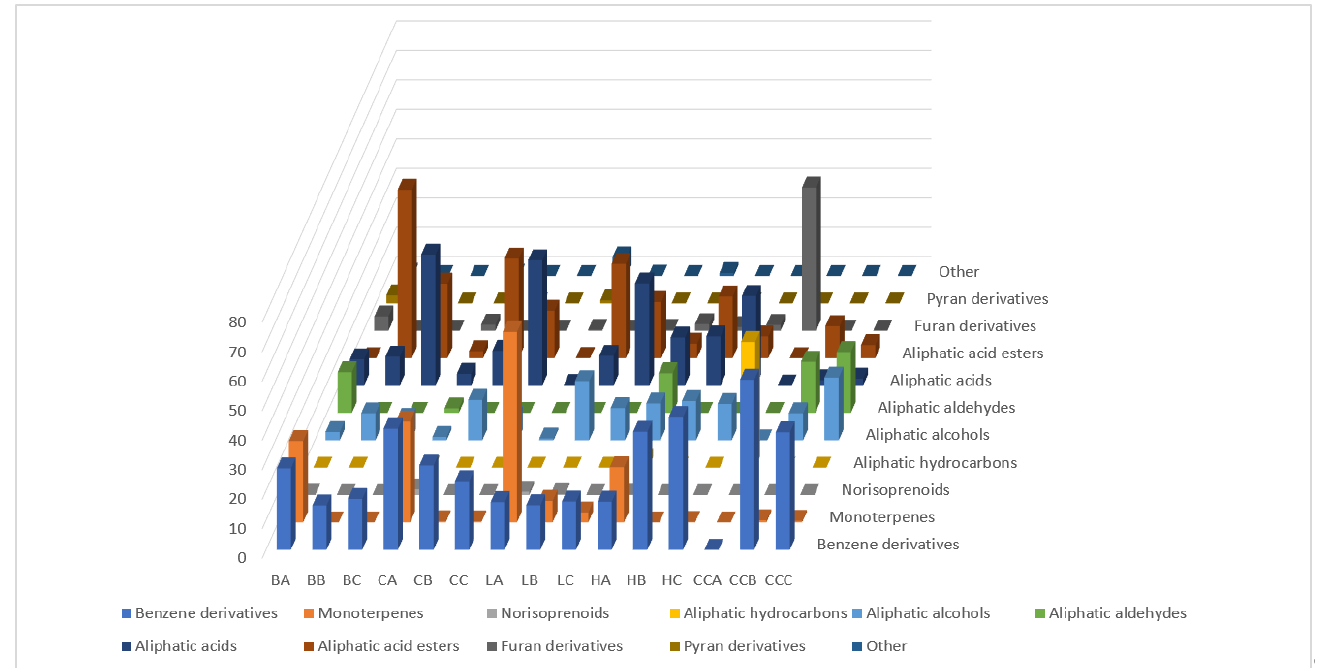
Figure 1. The overall percentages of the different volatile organic compound (VOC) structural groups in the analyzed honeys and meads by HS-SPME. BA, BB, BC—buckwheat honey, not boiled and boiled mead, respectively; CA, CB, CC—canola honey, not boiled and boiled mead, respectively; LA, LB, LC—lime tree honey, not boiled and boiled mead, respectively; HA, HB, HC—honeydew honey, not boiled and boiled mead, respectively; CCA, CCB, CCC— glucose–fructose syrup, not boiled and boiled mead, respectively.